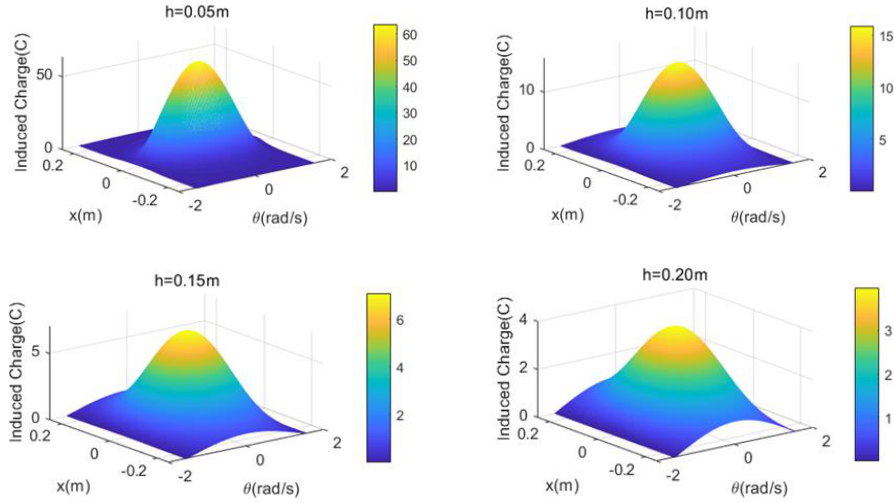
Figure 5. Distribution of the induced charge along ( θ , x ) .